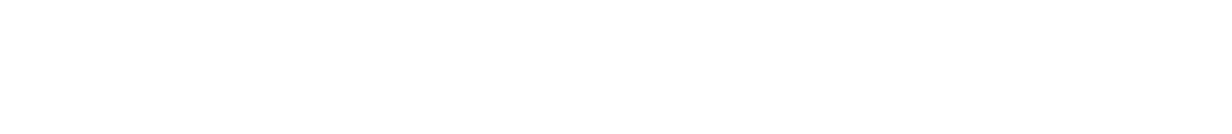
TABLE 6 | Characteristics of different methods of degrading antibiotics.